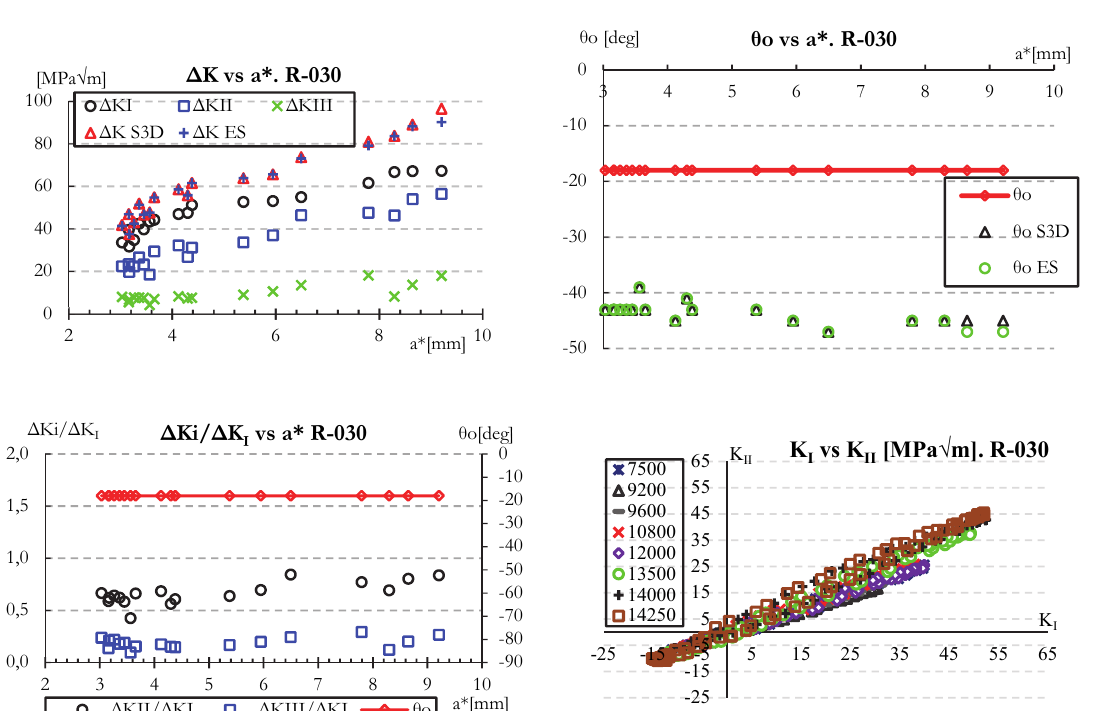
Figure 6: Crack tip parameters measured and calculated for specimen R-030, proportional tension and torsion loads.